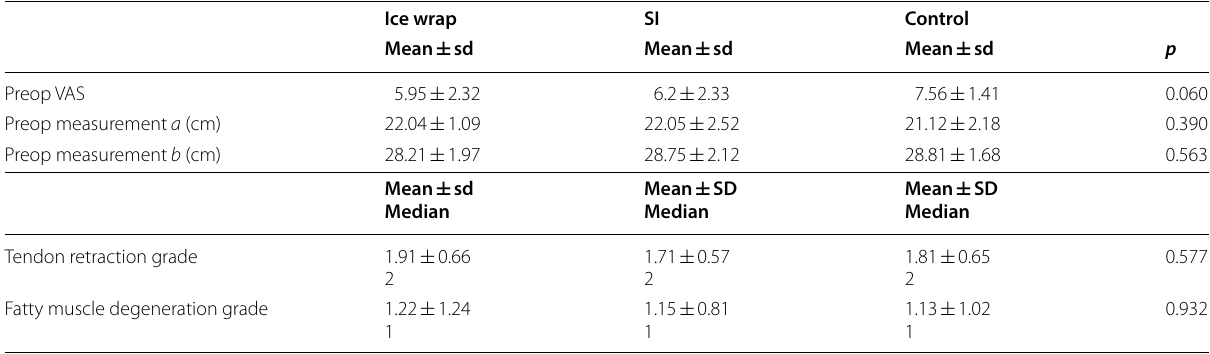
Table 1 Group comparison in terms of preoperative VAS, measurement a , measurement b , tendon retraction grade, and fatty muscle degeneration